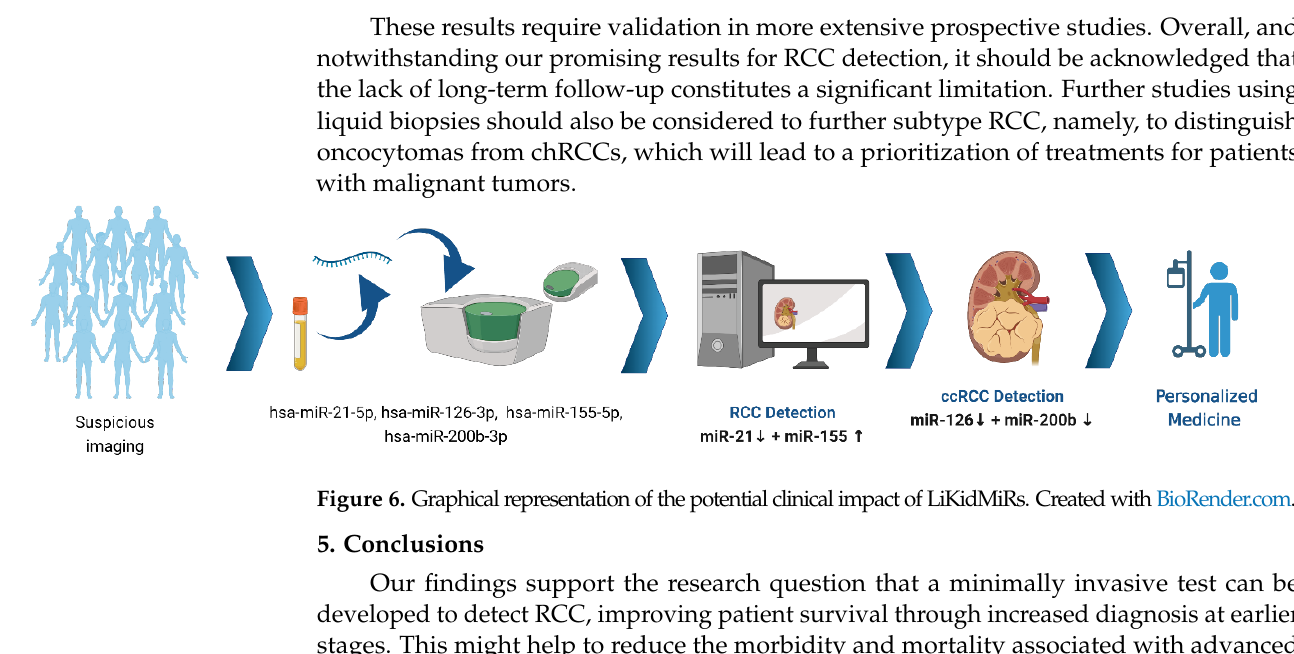
Performance of miRNAs as biomarkers for detection of Renal Cell Tumors., Figure S1: Violin plots with all points of miRNAs levels in Healthy Donors (HD) and Renal Cell Tumors (RCT) samples of hsa-miR-21-5p (A), hsa-miR-126-3p (B), hsa-miR-155-5p (C) and hsa-miR-200b-3p (D). Dashed lines indicate the interquartile range and horizontal line the median of miR levels. Abbreviations: HD — Healthy Donors; RCT — Renal Cell Tumors; n.s. — not significant, ** — p -value < 0.001, *** — p -value < 0.0001., Figure S2: Receiver Operating Characteristic Curve (without resampling analysis) of hsa-miR-21-5p (A) and hsa-miR-155-5p (B). Red line indicates the reference line and blue line the identity line for each miRNA. Abbreviations: AUC — Area Under the Curve; CI — Confidence Interval.